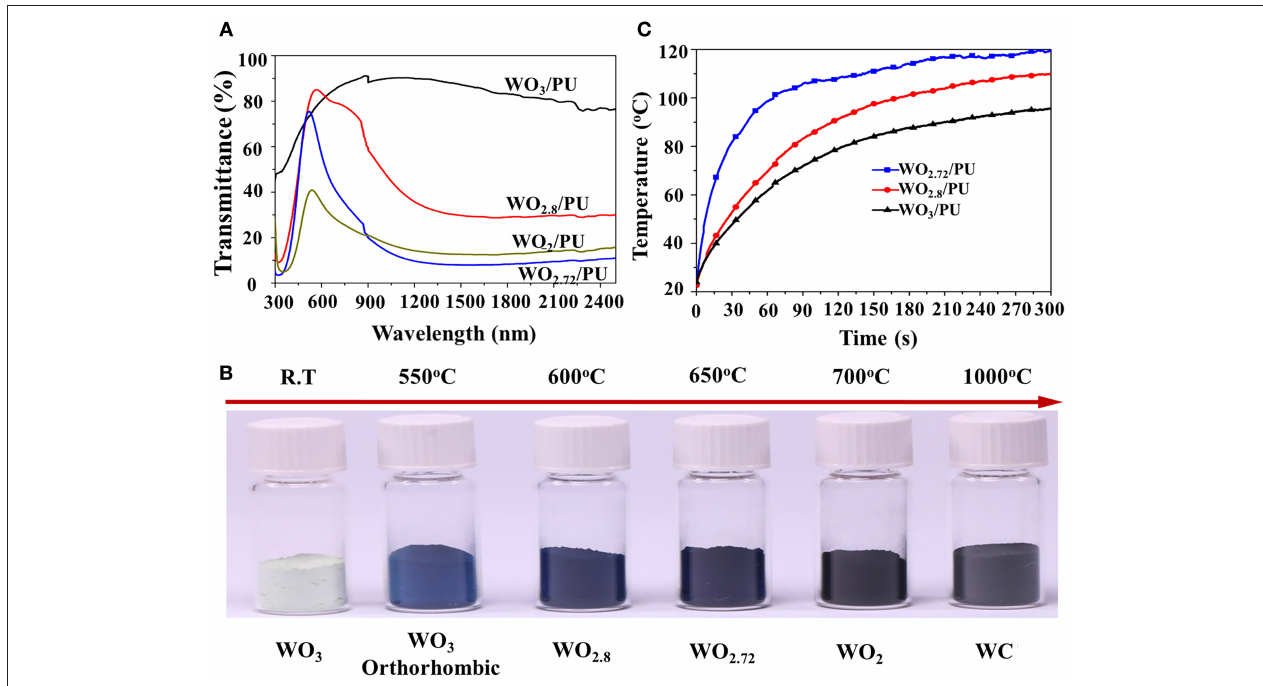
FIGURE 1 | Photothermalconversion properties of WO 2.72 /PU nanocomposites by (A) UV-Vis-NIR transmittance spectra, (B) variation in the color observed for reduced tungsten oxide powder, and (C) the temperature difference WO 3 /PU, WO 2.8 /PU, and WO 2.72 /PU with 7 wt % as a function of time under infrared light irradiation. Reproduced with permission ( Chala et al., 2017). Copyright 2017,